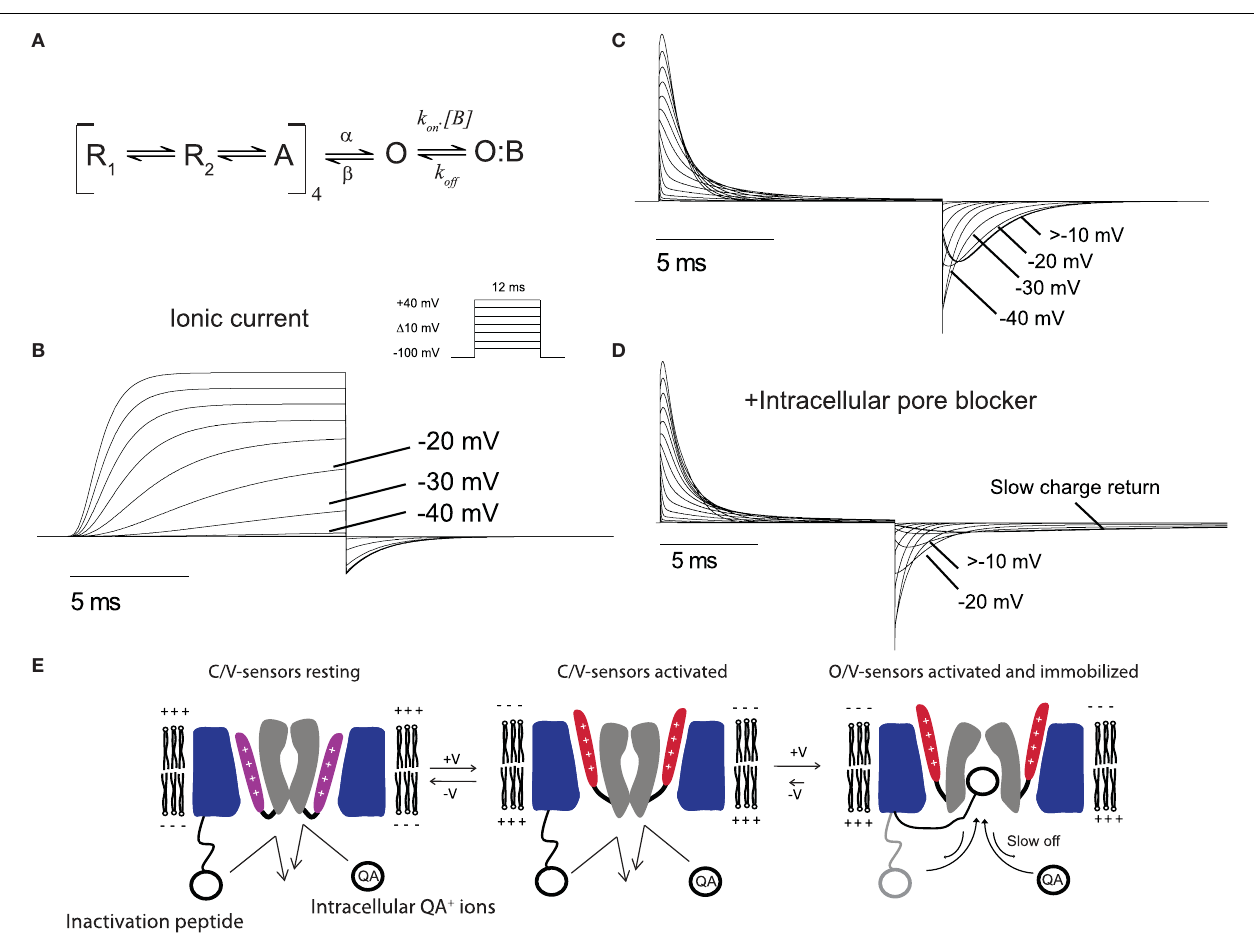
which the N-terminus inactivation peptide or QA ions can cause an immobilization of gating charges.The S1–S3 segments of theVSD is colored blue, S4 shown in purple (resting) or red (activated), and the pore domain S5–S6 grey. At resting negative membrane potentials the pore is closed at the bundle crossing and the S4 charge carrying segments of theVSD are in a resting state. Upon depolarization the S4 segments move outwards into the activated position before the pore opens at the intracellular gate. Once the pore is opened the N-terminus inactivation peptide or QA ions can enter the cavity.The pore is unable to close when these particles in the cavity and has the effect of slowing the voltage sensors return from the activated